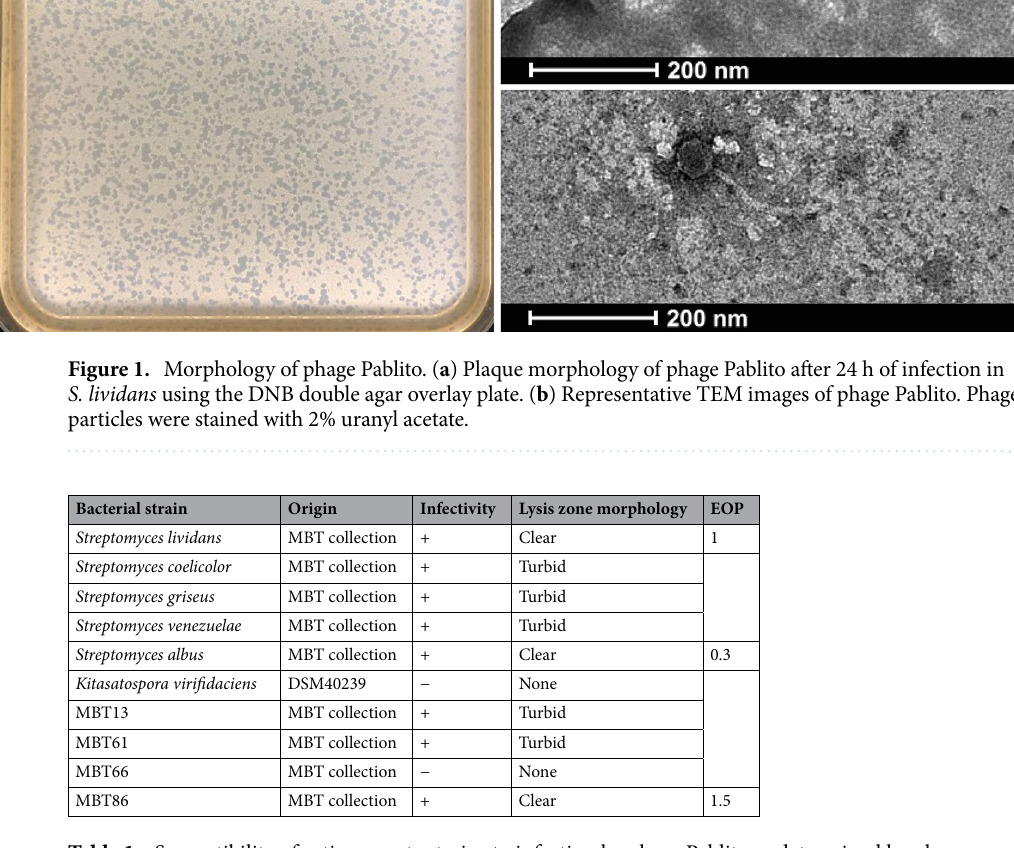
Table 1. Susceptibility of actinomycete strains to infection by phage Pablito as determined by plaque assays.